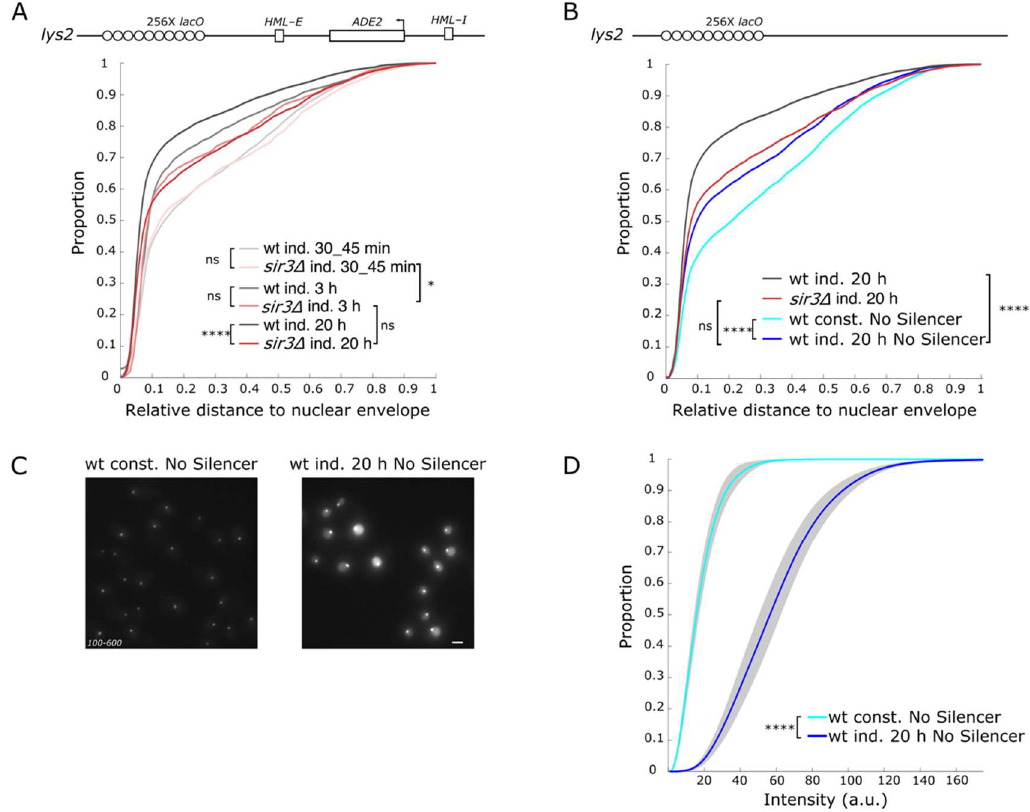
Figure 4. Perinuclear anchoring is partly Sir3 independent. ( A ) Cumulative distributions of the relative distance of the lys2::lacO E-ADE2-I locus to the nuclear periphery, in G1 cells, in strains expressing GFP-LacIR under the control of the GALS promoter in the WT (wt ind., yAT2078), and in a sir3 ∆ strain ( sir3 ∆ ind., yAT2370) after 30–45 min, 3 h, and 20 h of galactose induction. p > 0.01 is non-significant (ns), p ≤ 0.01 (*), p ≤ 0.00001 (****) and see Table S4 for statistics. ( B ) Cumulative distributions of the relative distance of lys2::lacO E-ADE2-I locus to the nuclear periphery in G1 cells, in strains expressing GFP-LacIR under the inducible GALS promoter in the WT (wt ind. yAT2078), and in a sir3 ∆ ( sir3 ∆ ind., yAT2370) strains after 20 h of galactose induction. Cumulative distributions of the relative distance of the lys2::lacO array locus (No Silencer) to the nuclear periphery in G1 cell, in strains expressing GFP-LacIR either under the inducible GALS promoter (wt ind. No Silencer, yAT3471) after 20 h of galactose induction or under the constitutive HIS3 promoter grown in galactose (wt const. No Silencer, yAT3420). p > 0.01 is non-significant (ns), p ≤ 0.00001 (****) and see Table S4 for statistics. ( C ) Representative fluorescent images (maximal projection of a Z-stack) of strains bearing the lys2::lacO array locus (No Silencer) and expressing GFP-LacIR either under the constitutive HIS3 promoter (wt const. No Silencer yAT3420) or under the inducible GALS promoter (wt ind. No Silencer yAT3471) at 20 h after galactose induction. Bar, 2 μm. ( D ) Cumulative distributions of the intensity of GFP foci in G1 cells, in strains bearing a lys2::lacO array locus (No Silencer) and expressing GFP-LacIR either under the constitutive HIS3 promoter (wt const. No Silencer yAT3420) or under the inducible GALS promoter (wt ind. No Silencer yAT3471) at 20 h after galactose induction. p > 0.01 is non-significant (ns), p ≤ 0.01 p ≤ 0.00001(****) and see Table S4 for statistics.